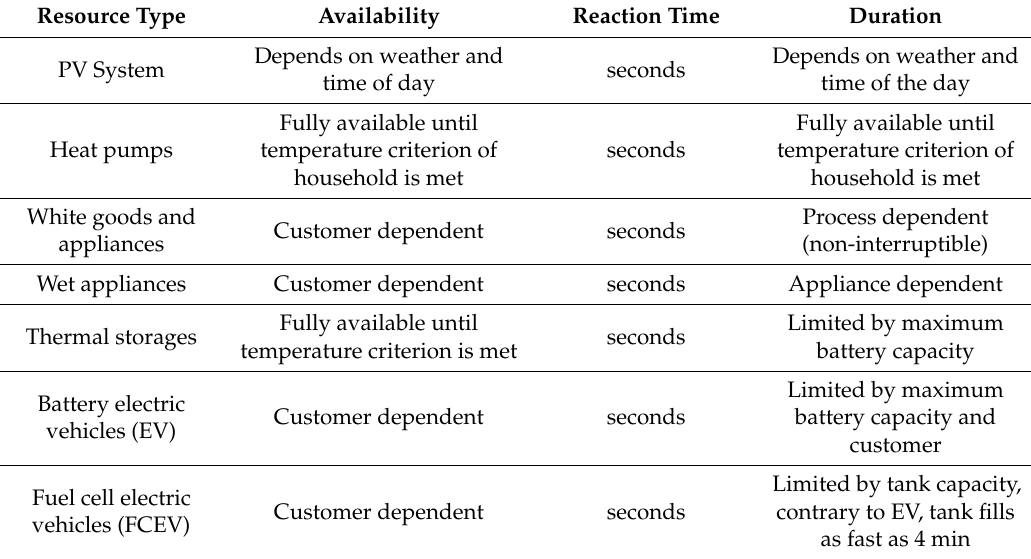
Table 3. Characteristics of resources in terms of